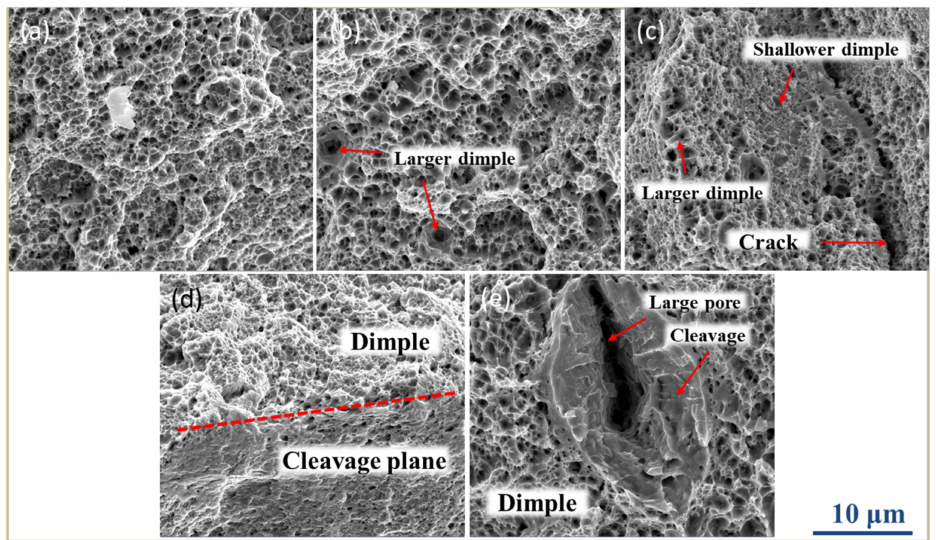
Figure 15. SEM images of fractures in SLM low-alloy steel samples grown with di ff erent EADs: ( a ) EAD = 142 J / mm 2 ; ( b ) EAD = 71 J / mm 2 ; ( c , d ) EAD = 47 J / mm 2 , and ( e ) EAD = 36 J / mm 2